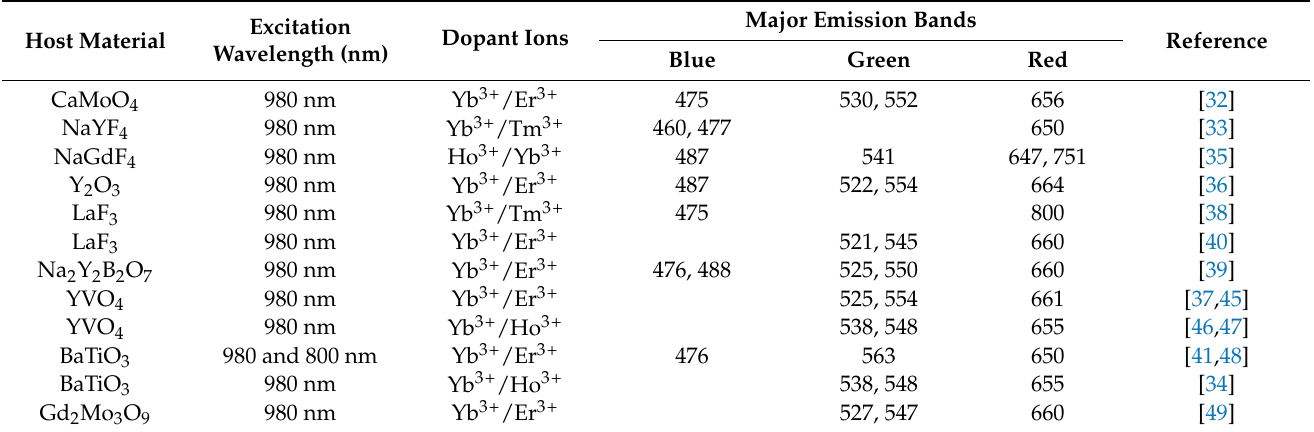
Table 1. Upconversion emission of various RE-doped materials.